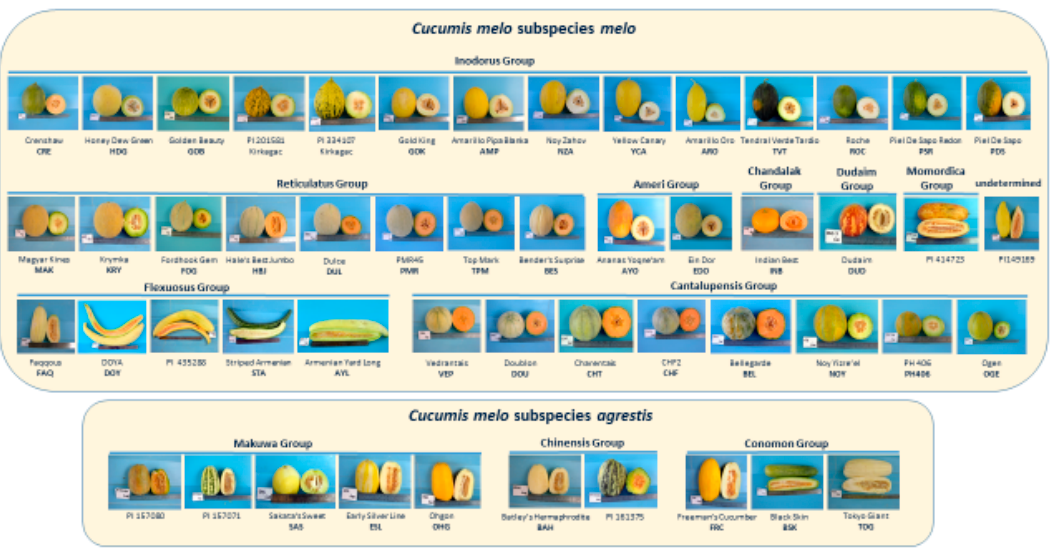
Figure 1. Fruits of the accessions used for this study, representing most of the cultivar-groups of Cucumis melo (listed in Table 1 and Table S1): Cantalupensis, Reticulatus, Inodorus, Ameri, Flexuosus, Dudaim, Momordica, Khandalak, Conomon, Chinensis, and Makuwa. Table 1. List of melon accessions used in this study. All accessions were analyzed for metabolites. The seven accessions not included in the GBS analysis are noted as NI. Further details regarding the accessions, including classification of climacteric behavior, are presented in Table